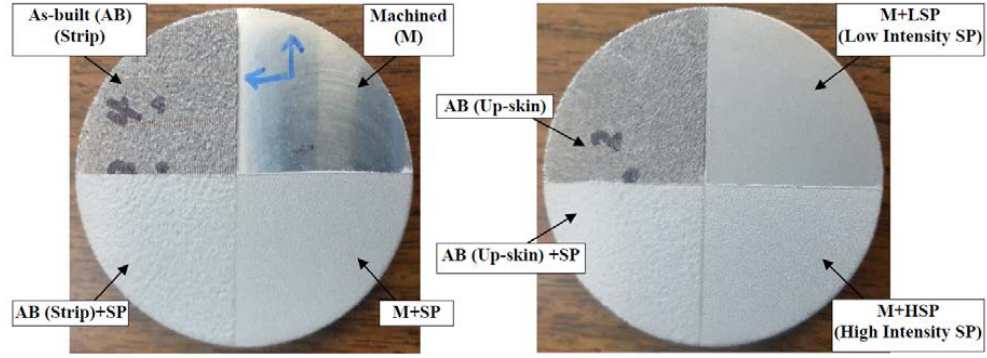
Figure 2. Various surface textures of the AlSi10Mg samples of as-built, rough machined, and shot-peened areas.